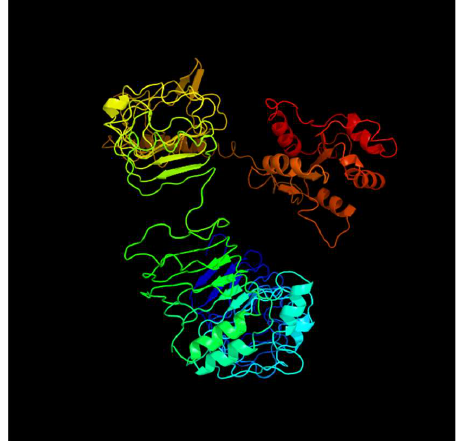
Figure 3. Genes marked in red are the target genes, and the direction of the arrow is the transcription direction. The number indicates the number of genes hidden between the two genes. White genes indicate genes that are different from the annotated genes. The name of the gene is given at the top. If it is not given, it is unnamed.